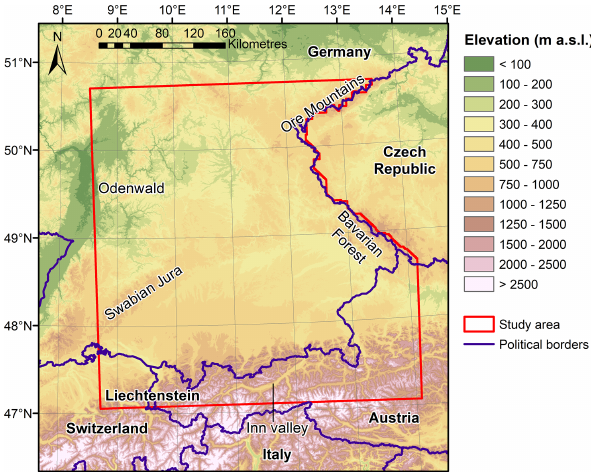
Figure 1. Topography of the investigated area. The elevation is based on the Shuttle Radar Topography Mission (SRTM) at a 90m resolution (Jarvis et al., 2021).